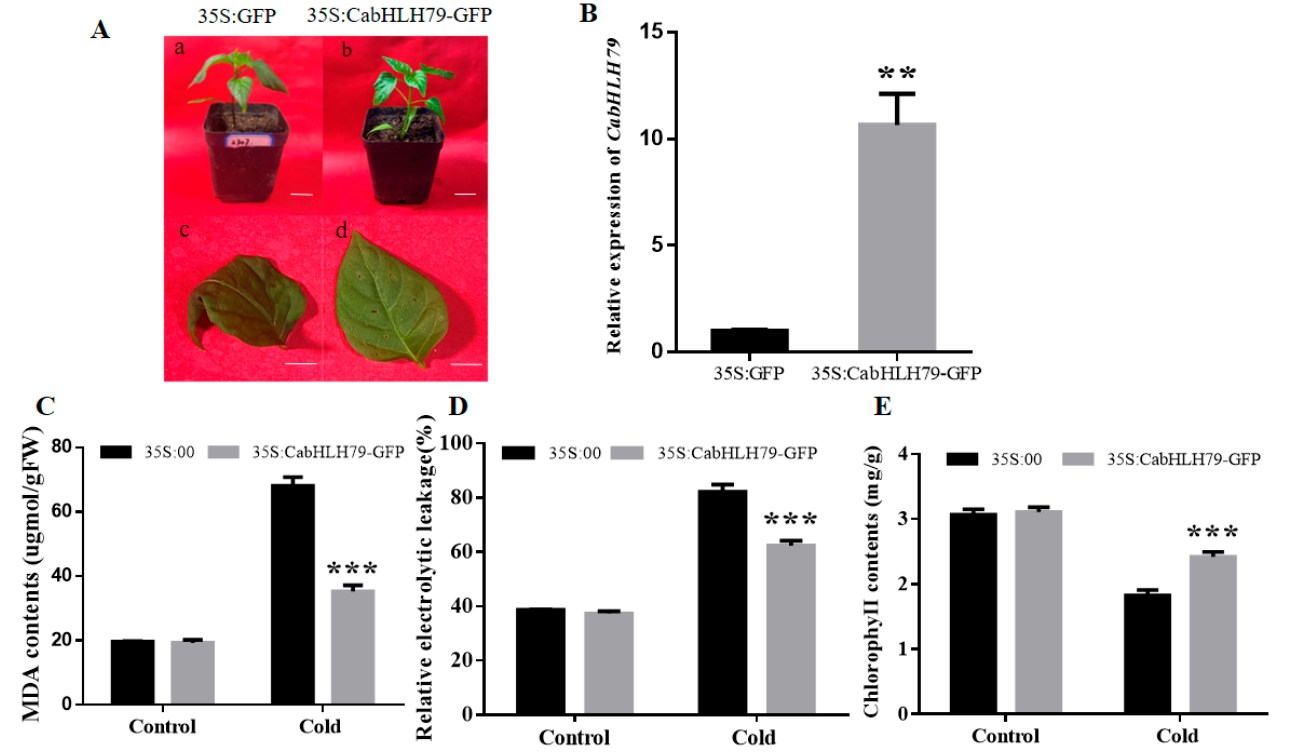
Figure 4. The measurement of physiological indices of CabHLH79- TO pepper plants under cold stress. ( A ) The transient expression of CabHLH79 gene alleviates the damage of pepper plants to low temperature. The white line in a, b is used as a scale bar (length 1.75 cm). The white line in c, d is used as a scale bar (length 0.5 cm). ( B ) The expression level of CabHLH79. ( C – E ) MDA, REL, chlorophyll contents. All data of three independent biological replicates were expressed by Means ± SDs. * representing significant difference (** p < 0.01, *** p < 0.001). Furthermore, the expression of cold-related genes and ROS-related genes ( CaERD15 , CaRD29A , CaCBF1A , CaPOD , CaCAT2 , and CaAPX1 ) was determined by RT-qPCR (Figure 5). After cold stress, the transcript levels of CaERD15 , CaRD29A , CaCBF1A , CaPOD ,